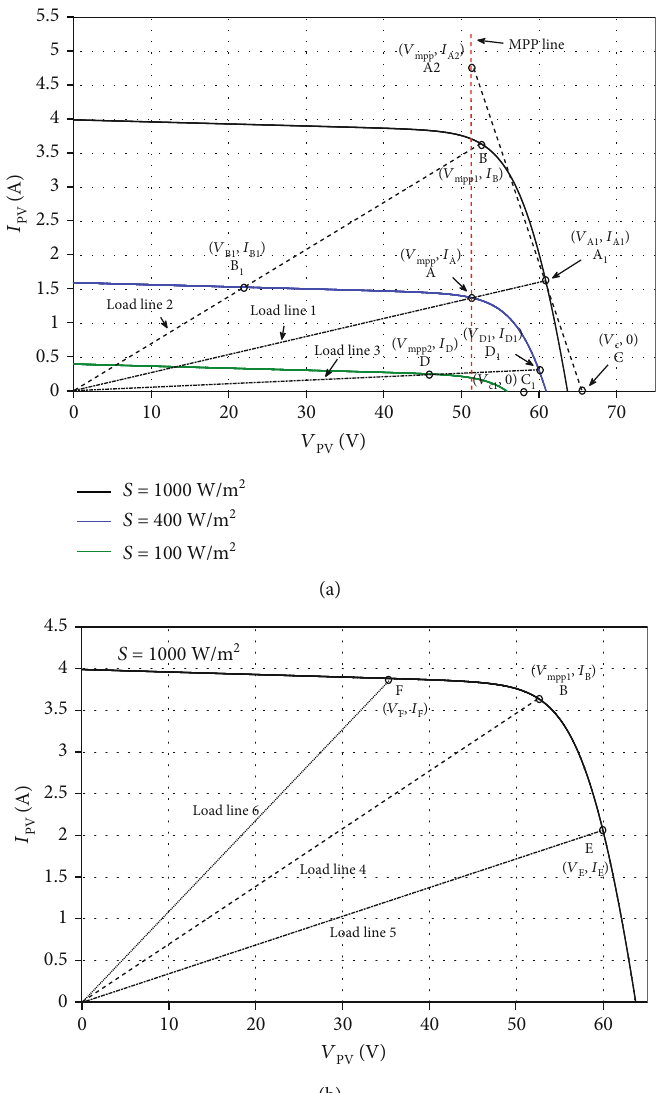
Figure 5: The variation in operating point during the variation in solar irradiation or load resistance: (a) the solar irradiation variation; (b) the load resistance